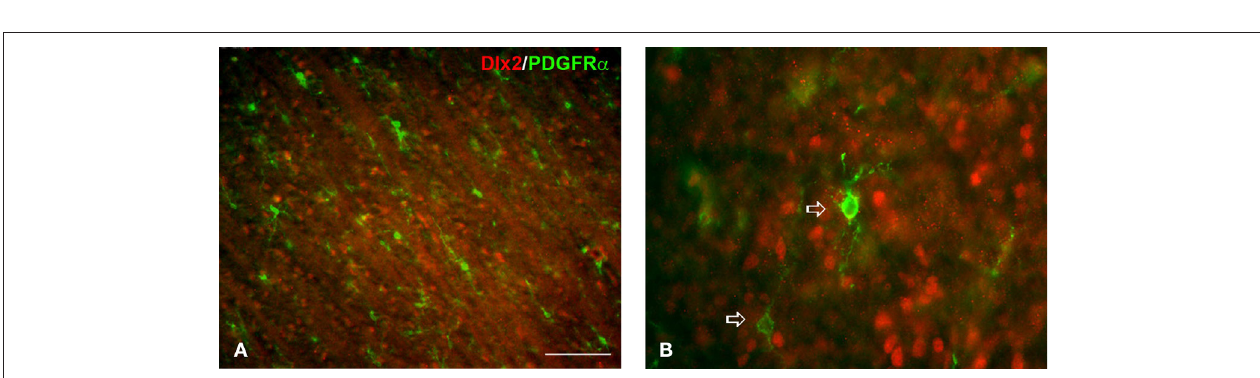
FIGURE 5 | The expression of Dlx2 and PDGFR α in 15 weeks old human fetal brain. Dlx2 (red) and PDGFR α (green, arrows) are usually not co-expressed in the emerging cortical white matter (A) and ganglionic eminence (B) . Scale bar: 100 µm (A) , 20 µm (B)